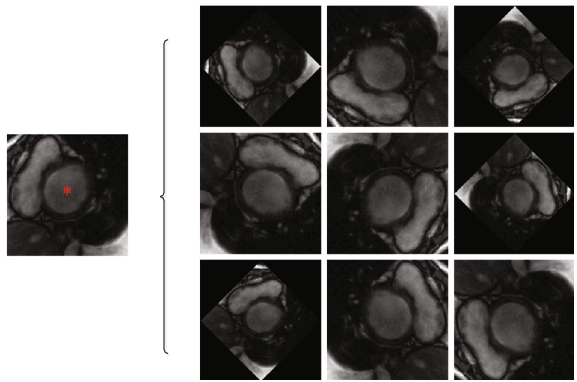
Figure 3: Data augmentation. The image on the left is the corresponding cropped ROI, and those on the right are augmented